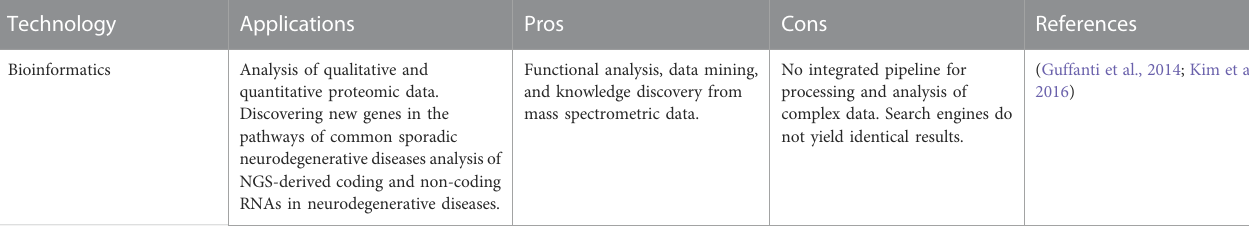
TABLE 1 ( Continued ) Various Techniques used in Proteomics along with their applications.